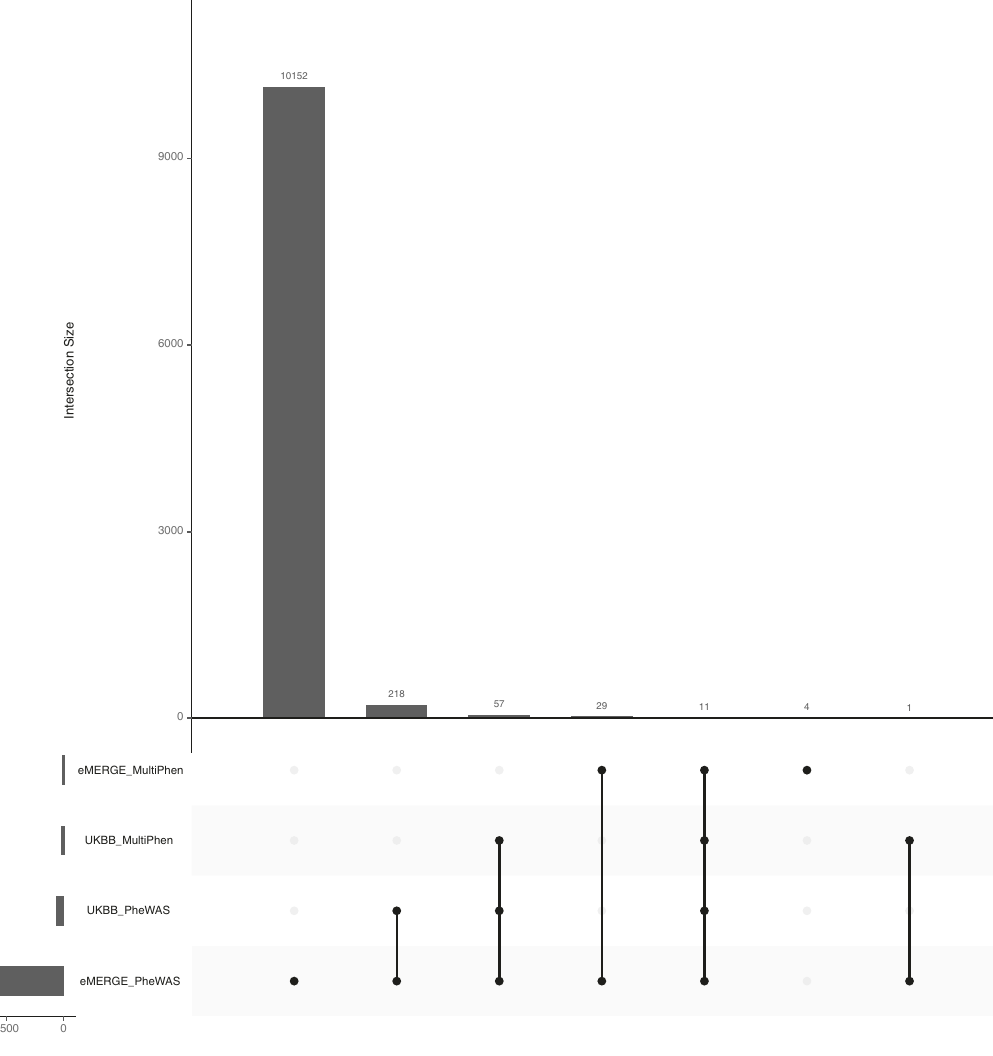
Fig. 2 Comparison of the number of signi fi cant loci identi fi ed by PheWAS and MultiPhen from eMERGE and UK Biobank. The p -value threshold is 1 × 10 − 4 . The number of loci are counted when they suggest signi fi cant associations with at least one phenotype. For PheWAS, we included the SNPs when its minimum p -value among phenotypes passed the threshold. Here, the total number of loci represents the independent loci we tested in both eMERGE and the UK